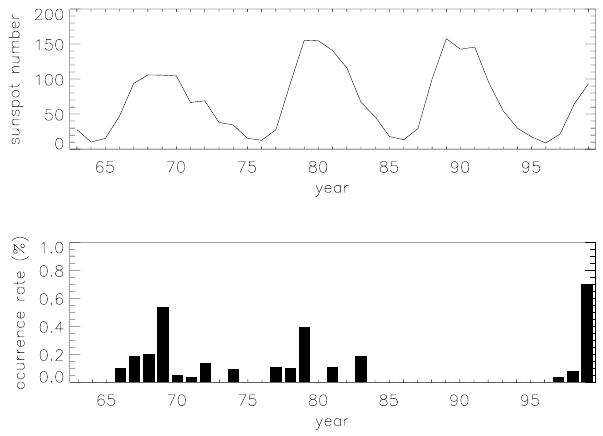
Fig. 3. Yearly sunspot numbers and annual occurrence rates of low- density solar wind (density 0.5 cm − 3 or less).